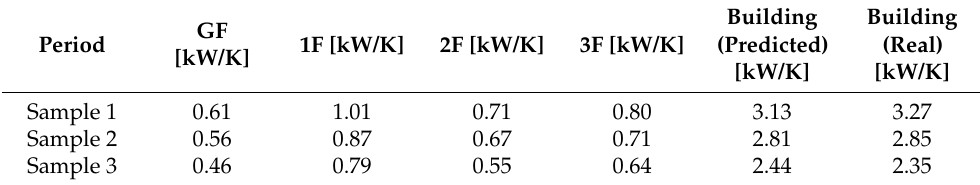
Table 5. HLC simple obtained per floor and for the entire building.